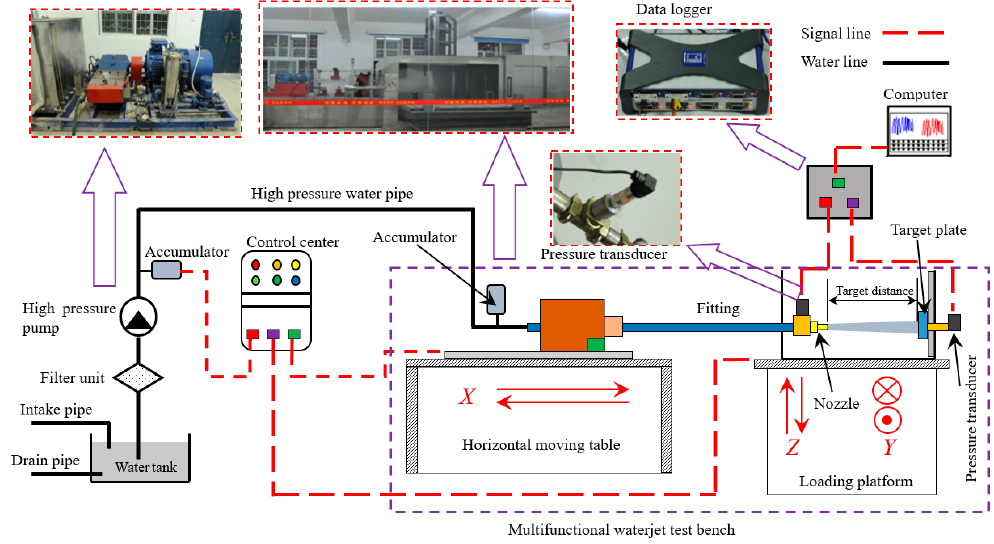
Figure 5. Connection diagram of the device.